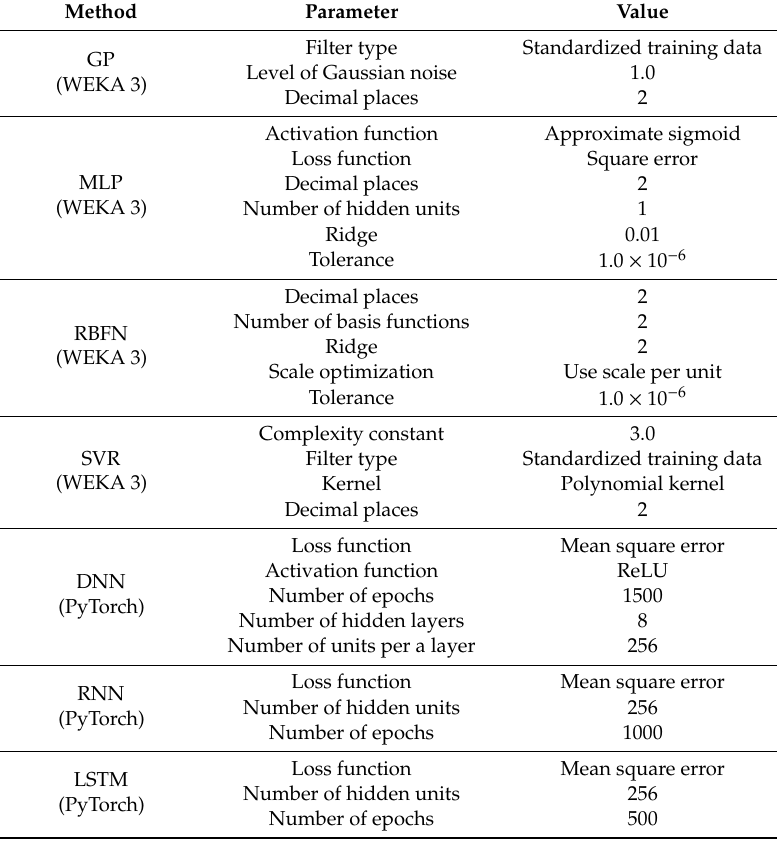
Table 5. Parameter values for machine learning (ML) methods.